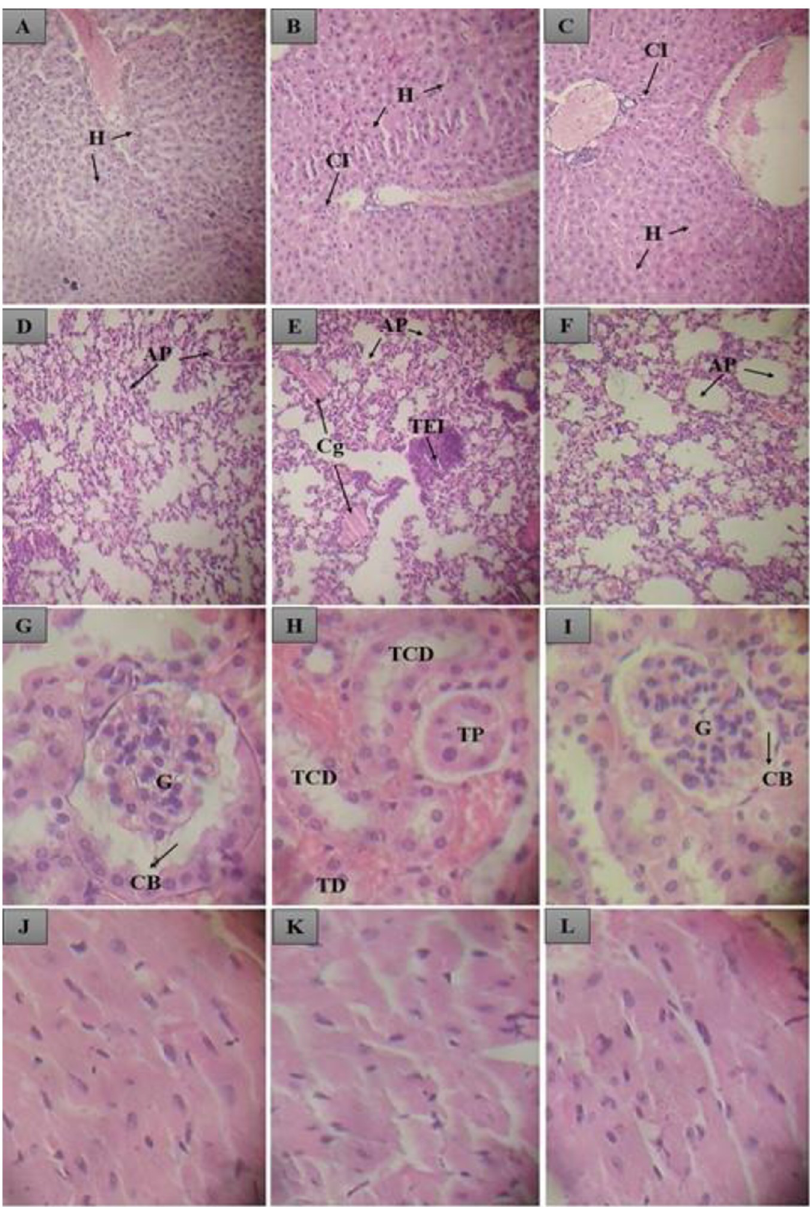
Fig 5. Histological section of animals treated orally with control and MAEON and MBEON. In A, the normal liver of a control group animal; In B and C, the liver of an animal treated with MAEON and MBEON, with normal hepatocytes (H) and the presence of inflammatory cells (CI). In D and F, the normal lungs of control and MBEON animals, where pulmonary alveoli was observed; In E, the lung of a MAEON group animal, where pulmonary alveoli (AP), congestion (Cg) and oedematous transudate with leukocyte infiltration (TEI) were observed. In G, H and I, the normal kidneys of control, MAEON and MBEON groups with glomerulus (G), Bowmam capsule (CB), distal tubule (DT), proximal tubule (TB). In J, K and L, normal hearts are observed from the control group, MAEON and MBEON.